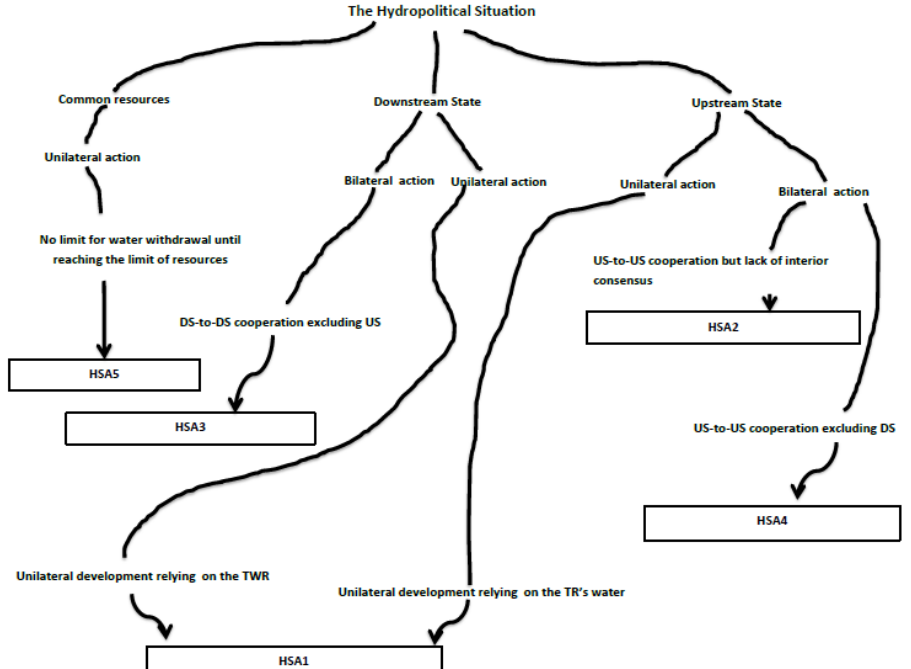
Figure 6. The cognitive map for studying the presented HSAs.